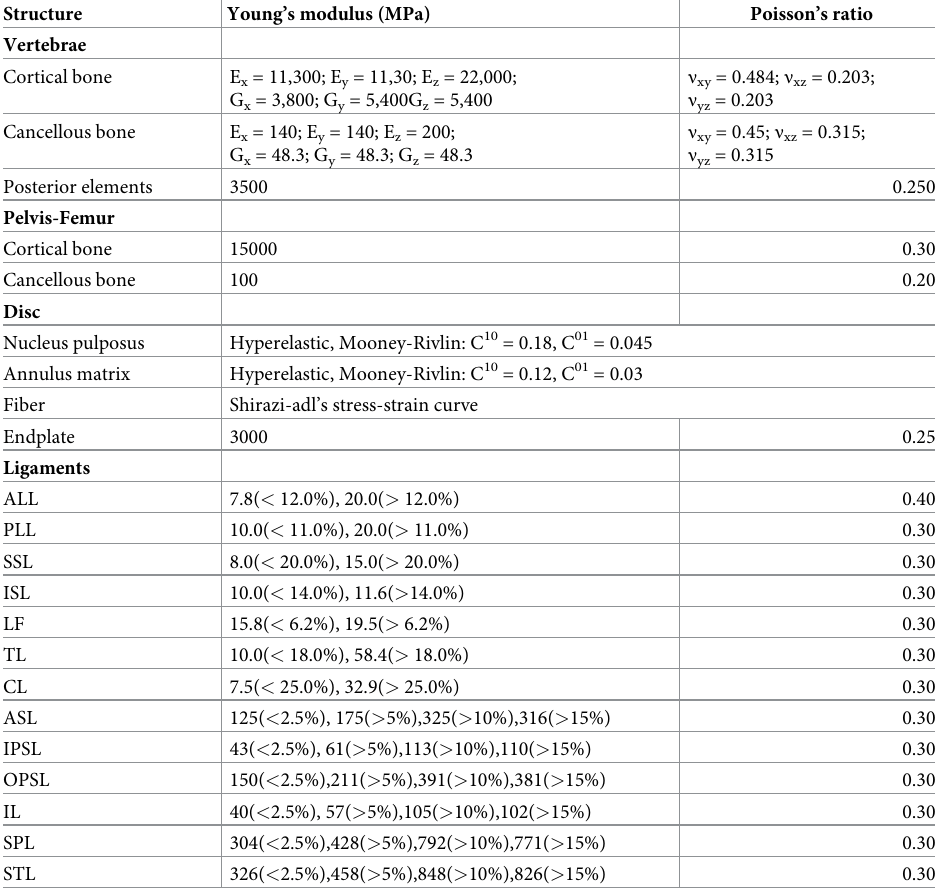
Table 1. Material properties of the